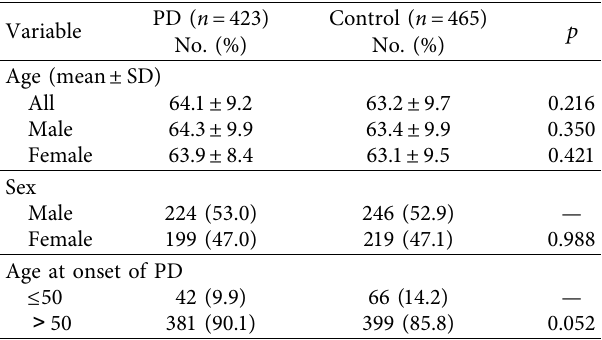
Table 1: Demographic characteristics of PD group and control